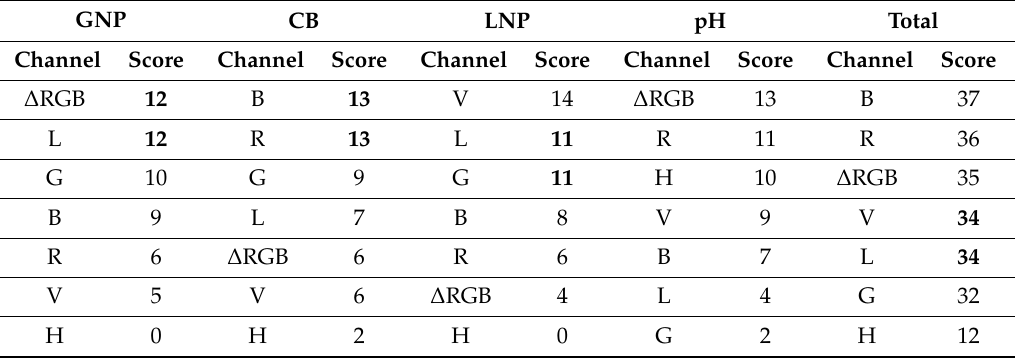
Table 3. Scores of the individual channels in each color system, as well as overall scores for all color systems. Shared scores are in